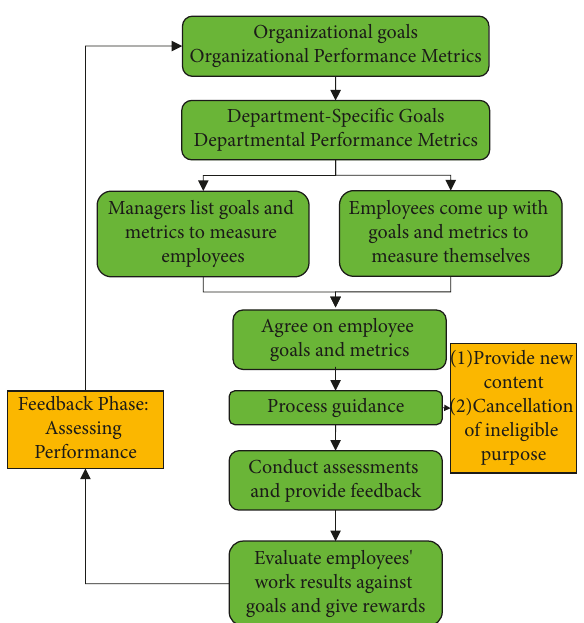
Figure 4: Flow chart of performance evaluation based on man- agement by